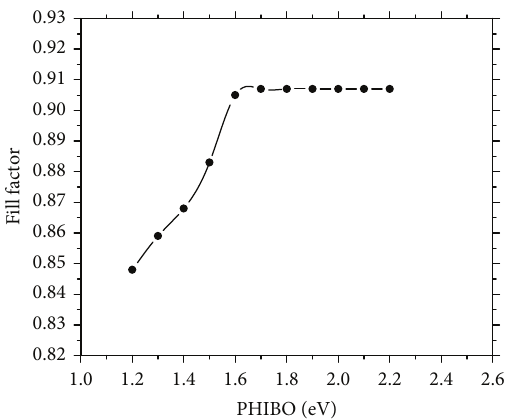
Figure 5: PHIBO versus fi ll factor plot of the proposed solar cell ’ s front